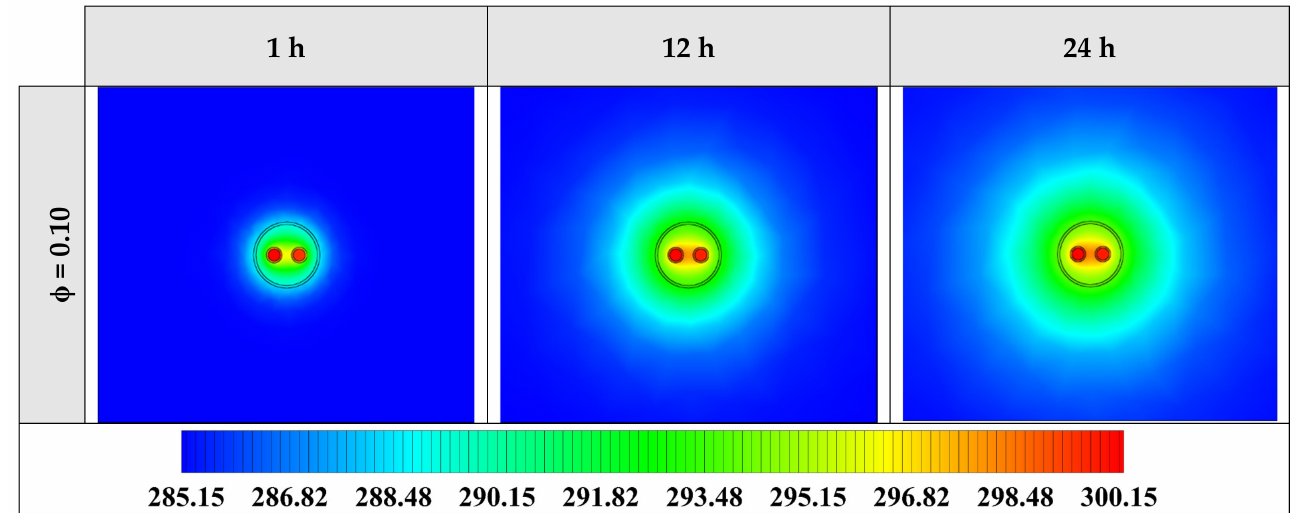
Figure 15. Two-dimensional (2D) contours of the temperature distribution of the BHE at various hours of operating using Ag-MgO/water hybrid nanofluid at φ = 0.10 and Re = 3200 (Top view at Z =